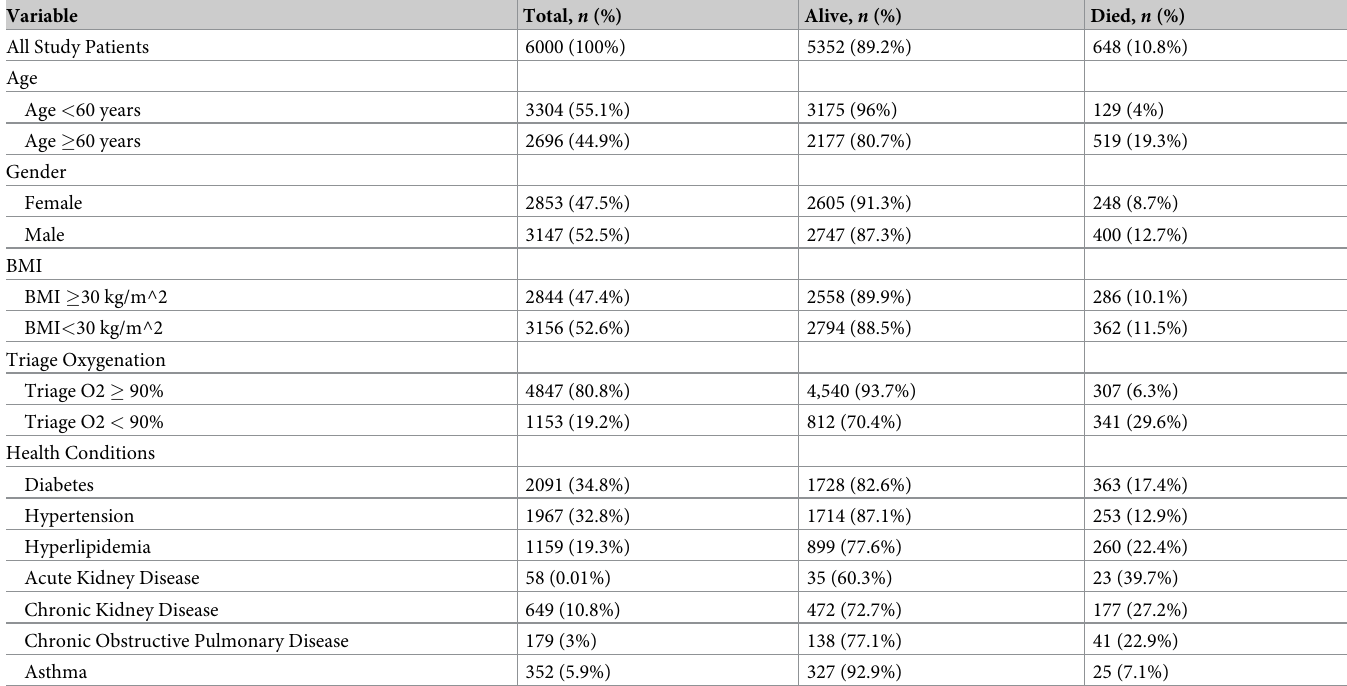
Table 3. Descriptive characteristics of study patients, demographics, and survival status in the prediction tool development (n = 6,000 patients) dataset.